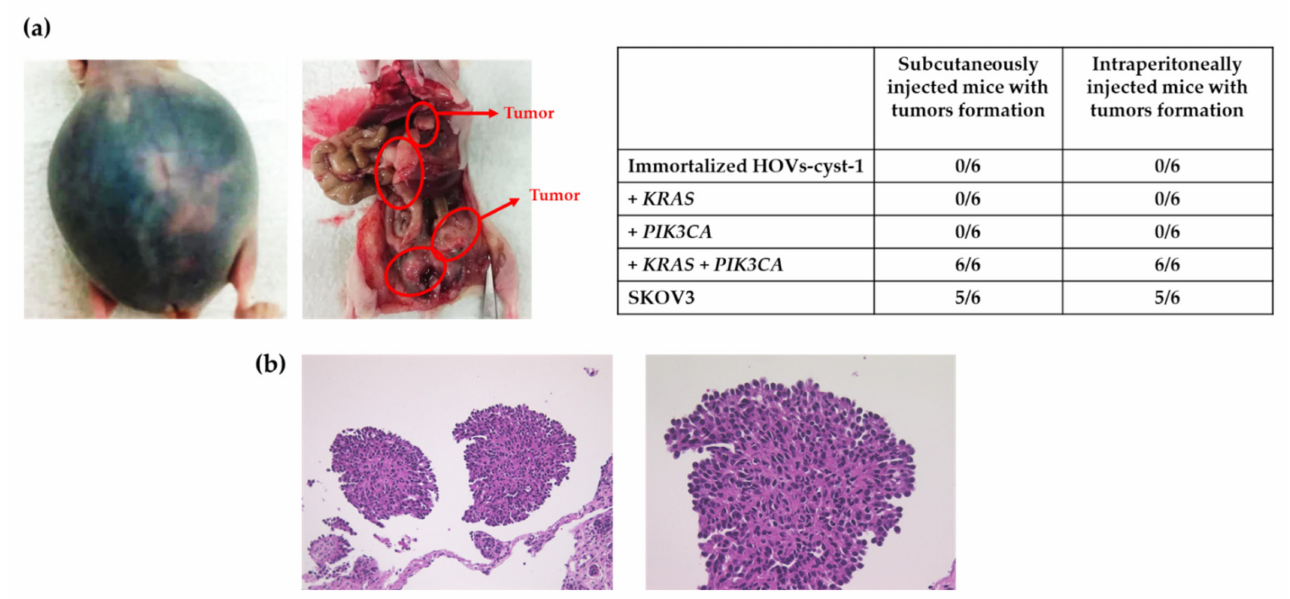
Figure 5. Mouse xenograft assay using HOVs-Cyst-1 cells with genetic mutations (either KRAS or PIK3CA , or both KRAS and PIK3CA ). ( a ) Intraperitoneal inoculation resulted in tumor formation only when HOVs-1-Cyst-1 cells were characterized by both KRAS and PIK3CA mutations. The other series of HOVs-Cyst-1 cells did not form tumors in nude mice. ( b ) Hematoxylin and eosin (H & E) staining of HOVs-Cyst-1 cells with both KRAS and PIK3CA mutations showing a micropapillary LGSOC invasive pattern with low nuclear atypia without